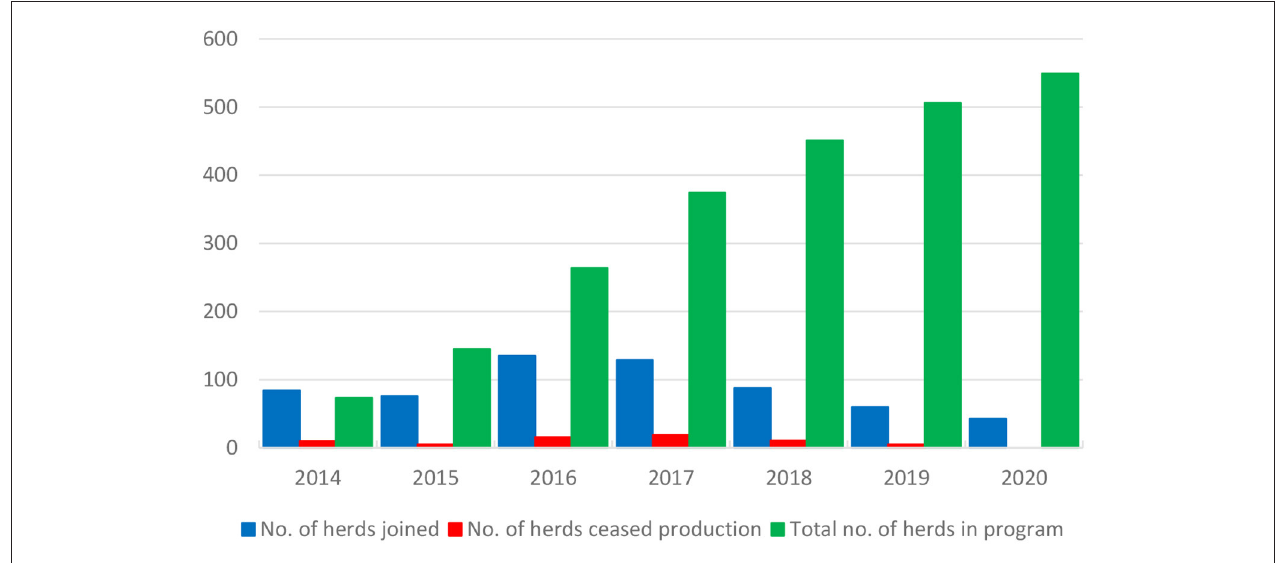
FIGURE 7 | Number of herds that have annually joined and withdrawn from (ceased production) the program and total number of herds in the M. bovis control program in